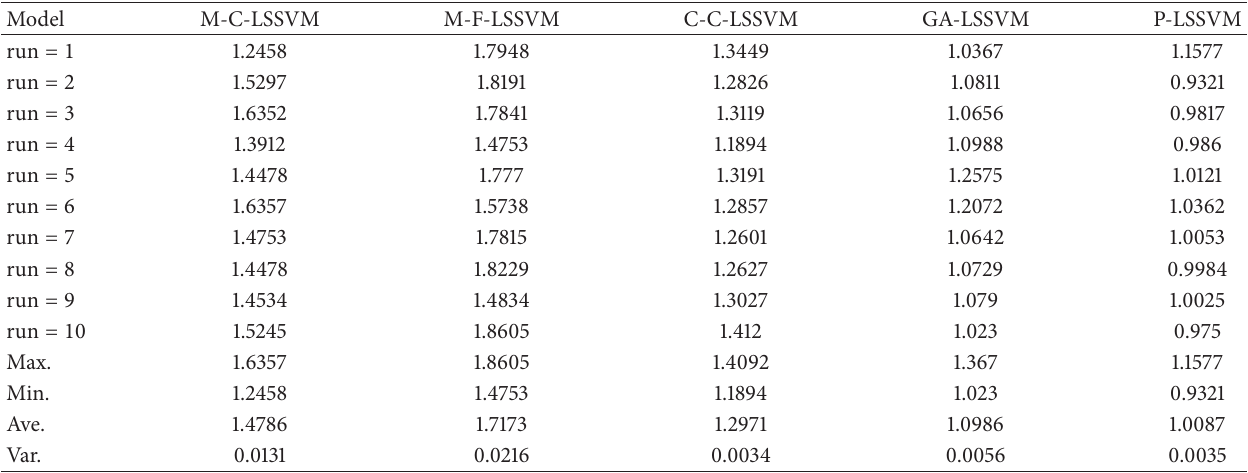
Table 7: Five models predicted error based on NMSE for interphone band.